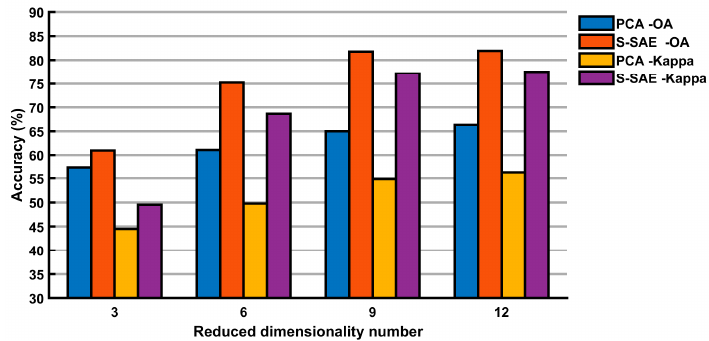
Figure 18. OA and Kappa of classification results by PCA and S-SAE with different reduced features.